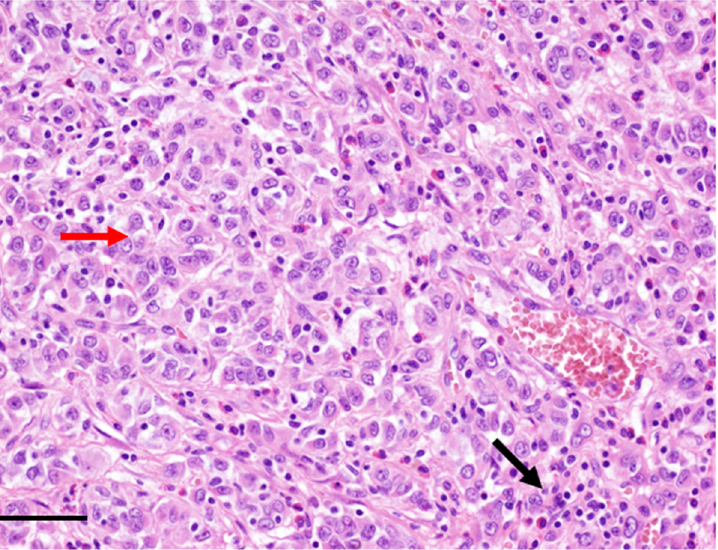
Figure 2. Hematoxylin and eosin stain of an EIMS composed of epithelioid cells (red arrow) and inflammatory infiltrates (black arrow). Bar = 10 µm.